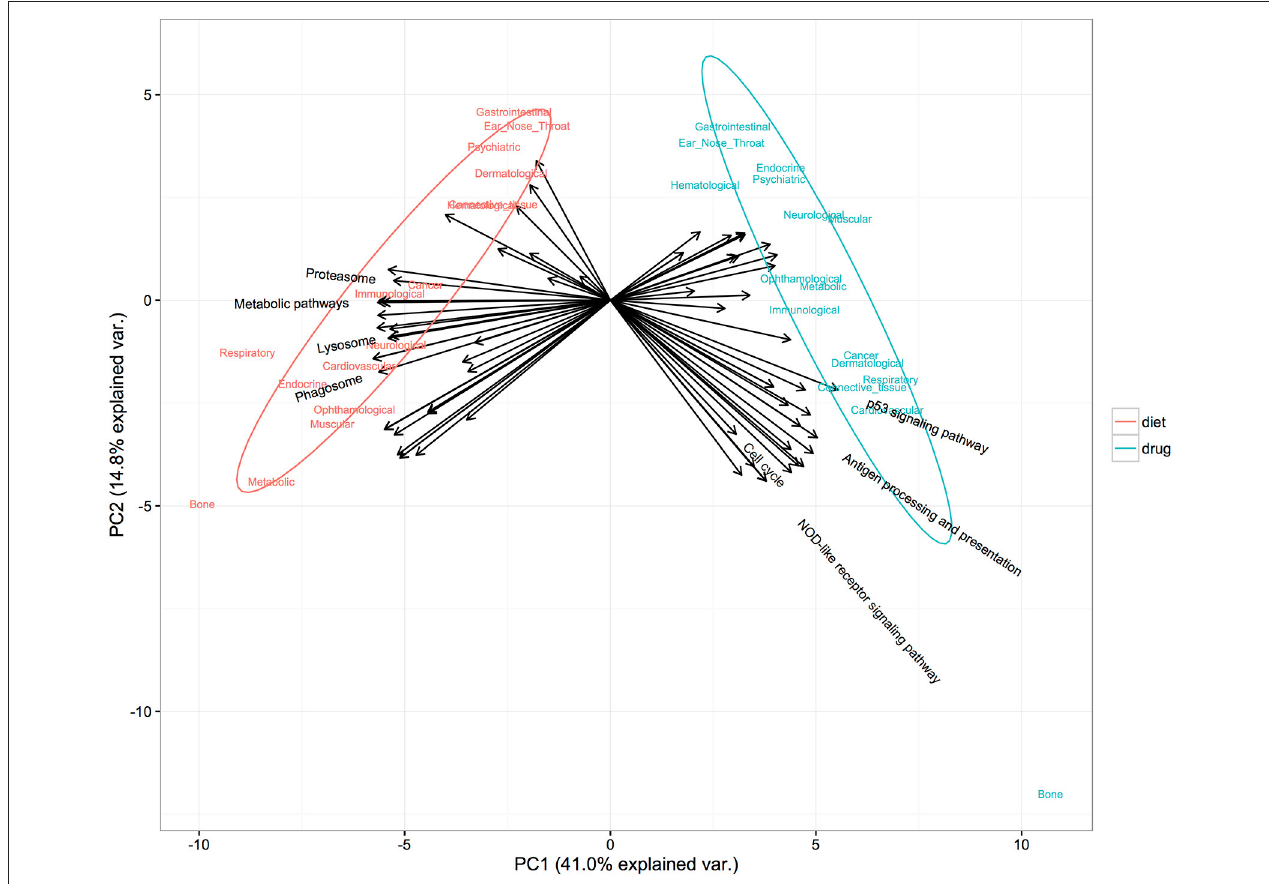
FIGURE 5 | Distinct pathways enriched in diet and drug gene expression signatures found anti-correlated with diseases. The first two components from PCA accounted for 55.8% of the total variance. Colors denote two classes of administrations: diet (red) and drug (blue). Arrows denote representative variables (pathways) with a relative contribution ranked in the top 30 to either of the principal components and are labeled with pathway names.